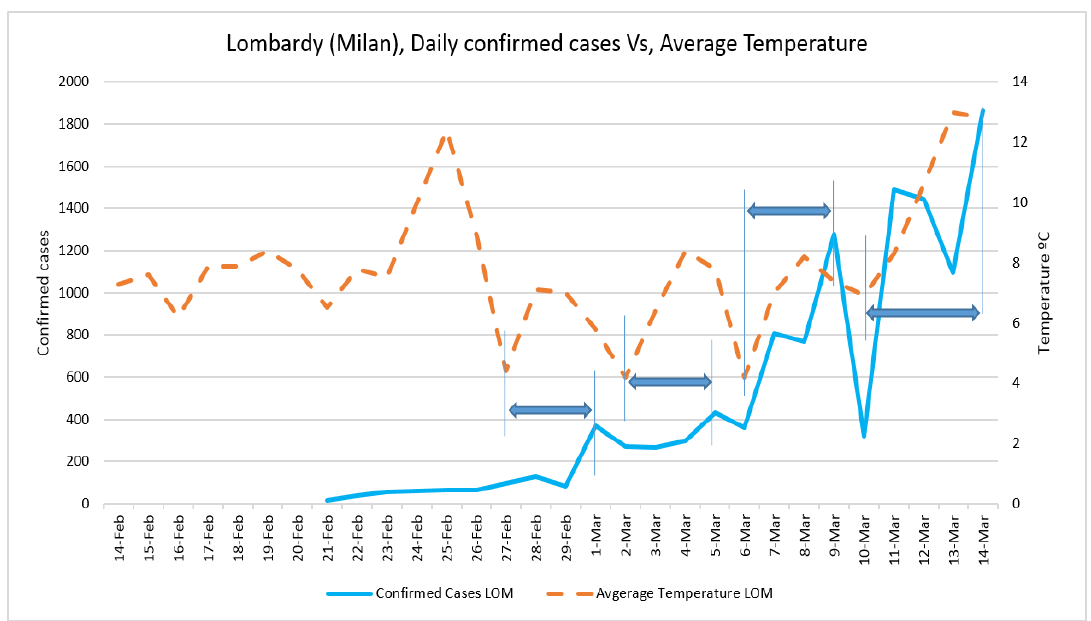
Figure 4. Daily confirmed cases of COVID-19 in Lombardy and average temperature.